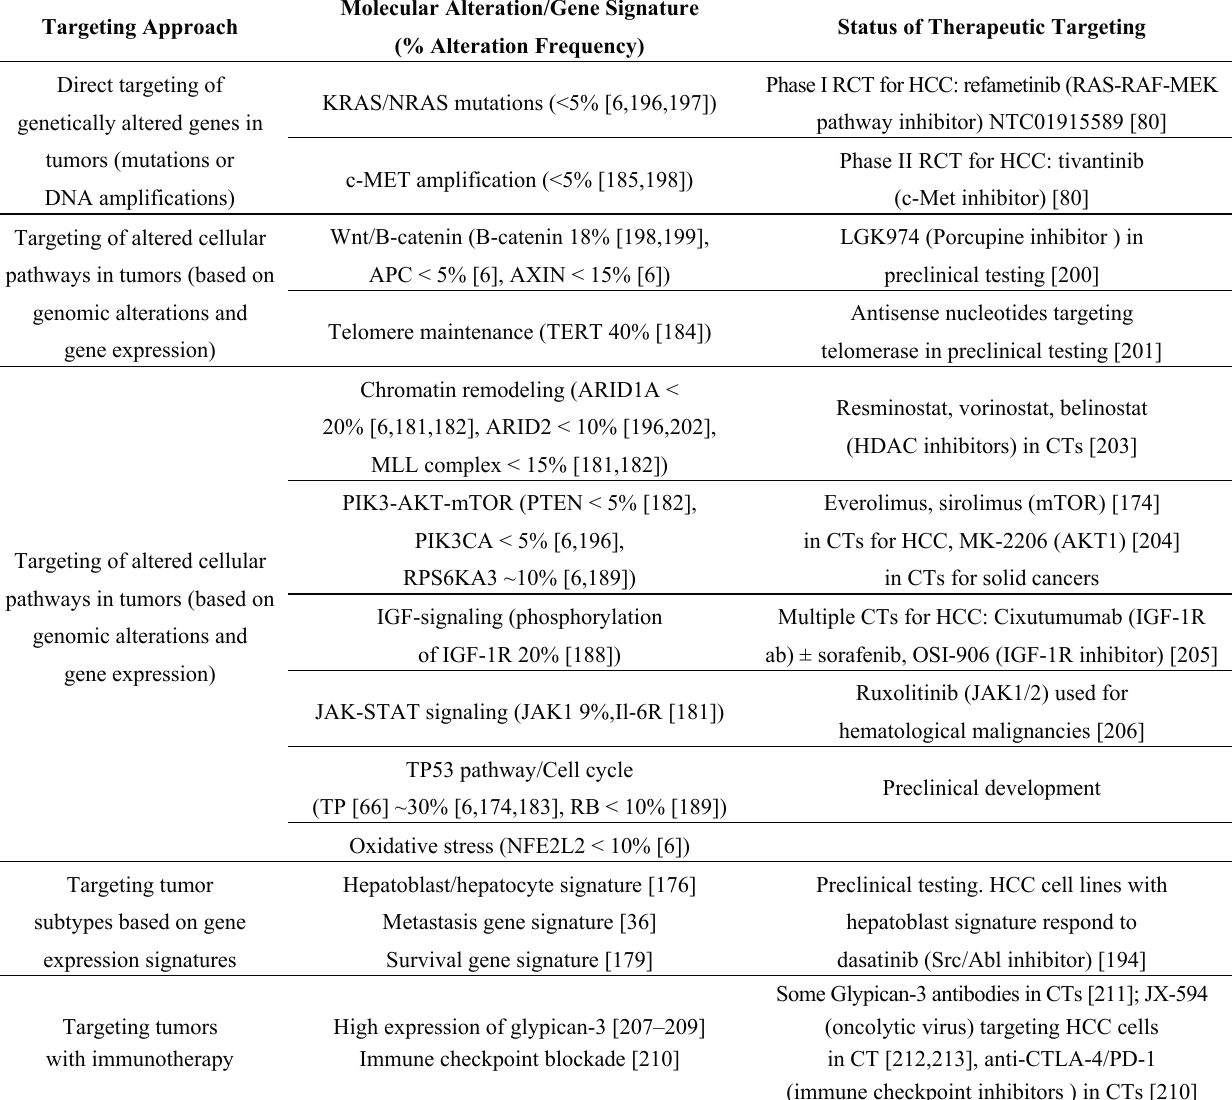
Table 4. Emerging therapeutic targeting approaches for